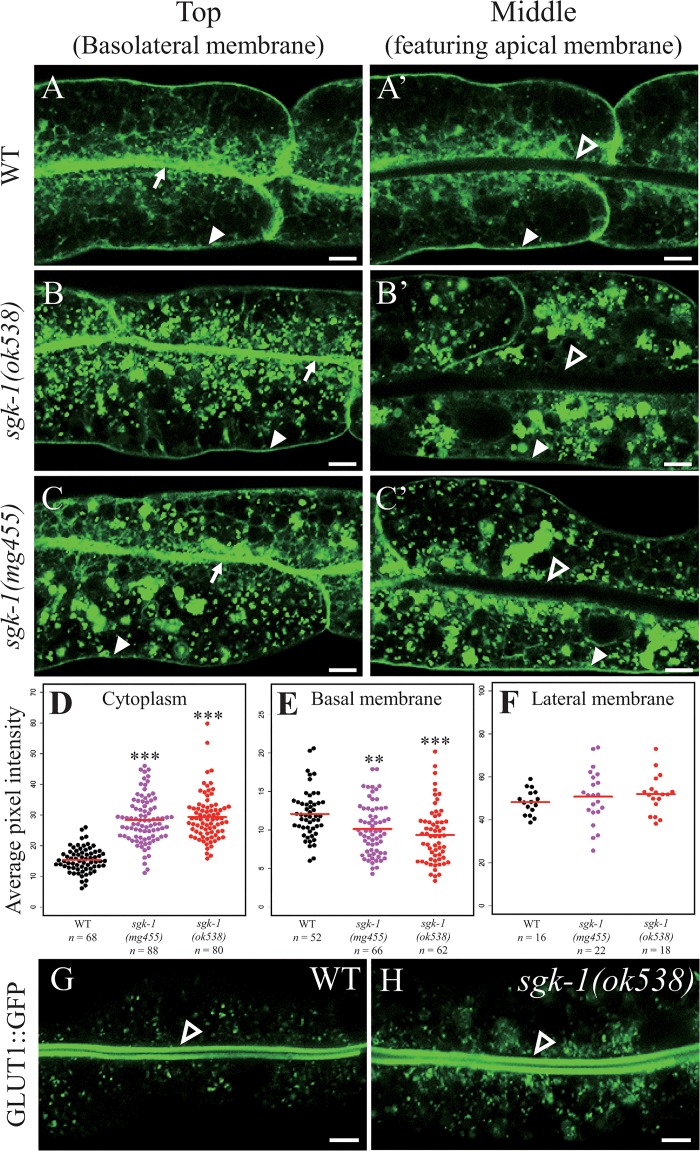
Defective membrane trafficking of hTAC::GFP and GLUT1::GFP in sgk-1(null) mutants.Confocal images of wild type (A, A’, G), sgk-1(ok538) (B, B’, H) and sgk-1(mg455) (C, C’) intestinal cells expressing hTAC::GFP or GLUT1::GFP. The apical, basal and lateral membranes are indicated by open arrow heads, solid arrow heads and arrows, respectively. Scale bars: 5 μm. See Fig 2 legend for explanations of different focal planes. (D-F) Quantitation of average pixel intensity of hTAC::GFP localized in the cytoplasm (D), on the basal membrane (E) or lateral membrane (F). The average intensity is denoted with a red line. *** P value <0.001, ** P value <0.01 (Wilcoxon rank sum test).